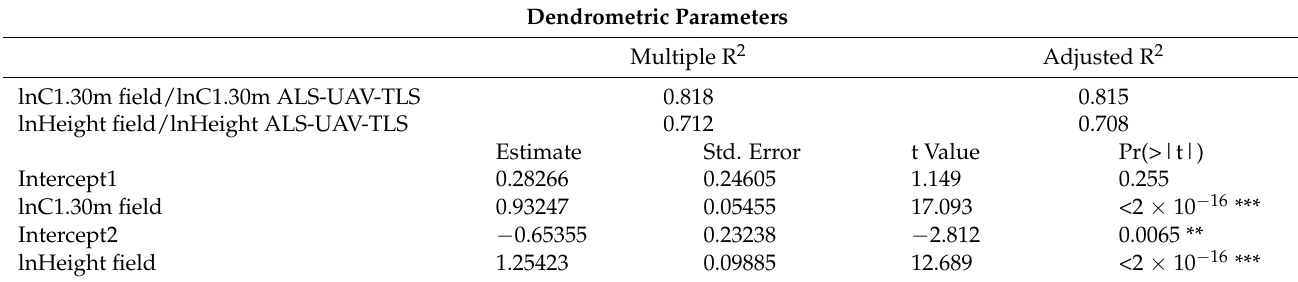
Figure 11. Relationship between C1.30m and tree heights measured in the field and those extracted from ALS-UAV-TLS data, represented using linear regression with logarithmic transformation. Table 6. Relationship between dendrometric parameters (H, C1.30m), biomass, and carbon stock (aboveground, belowground, and total) measured and estimated with field measurements and from UAV-ALS-TLS data using linear regression with a logarithmic